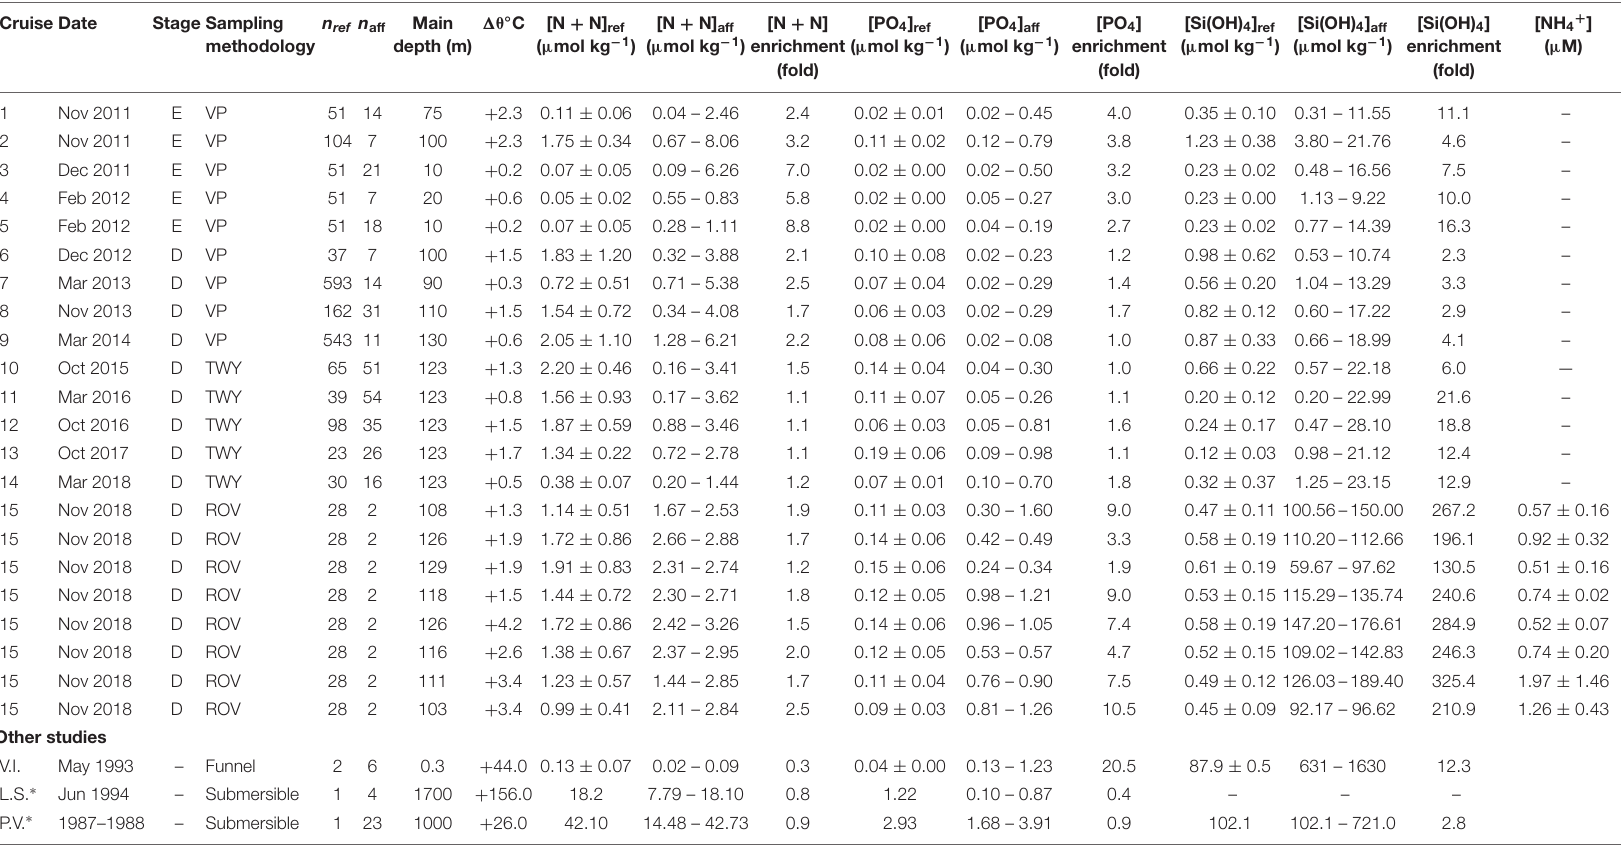
TABLE 1 | Information from each cruise carried out in Tagoro volcano.